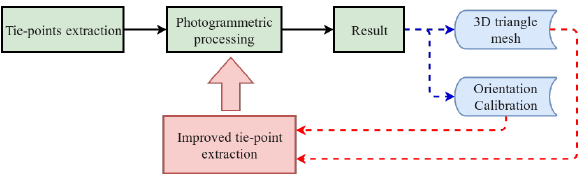
Figure 1. A second iteration based on tie points of high quality extracted with a first processing